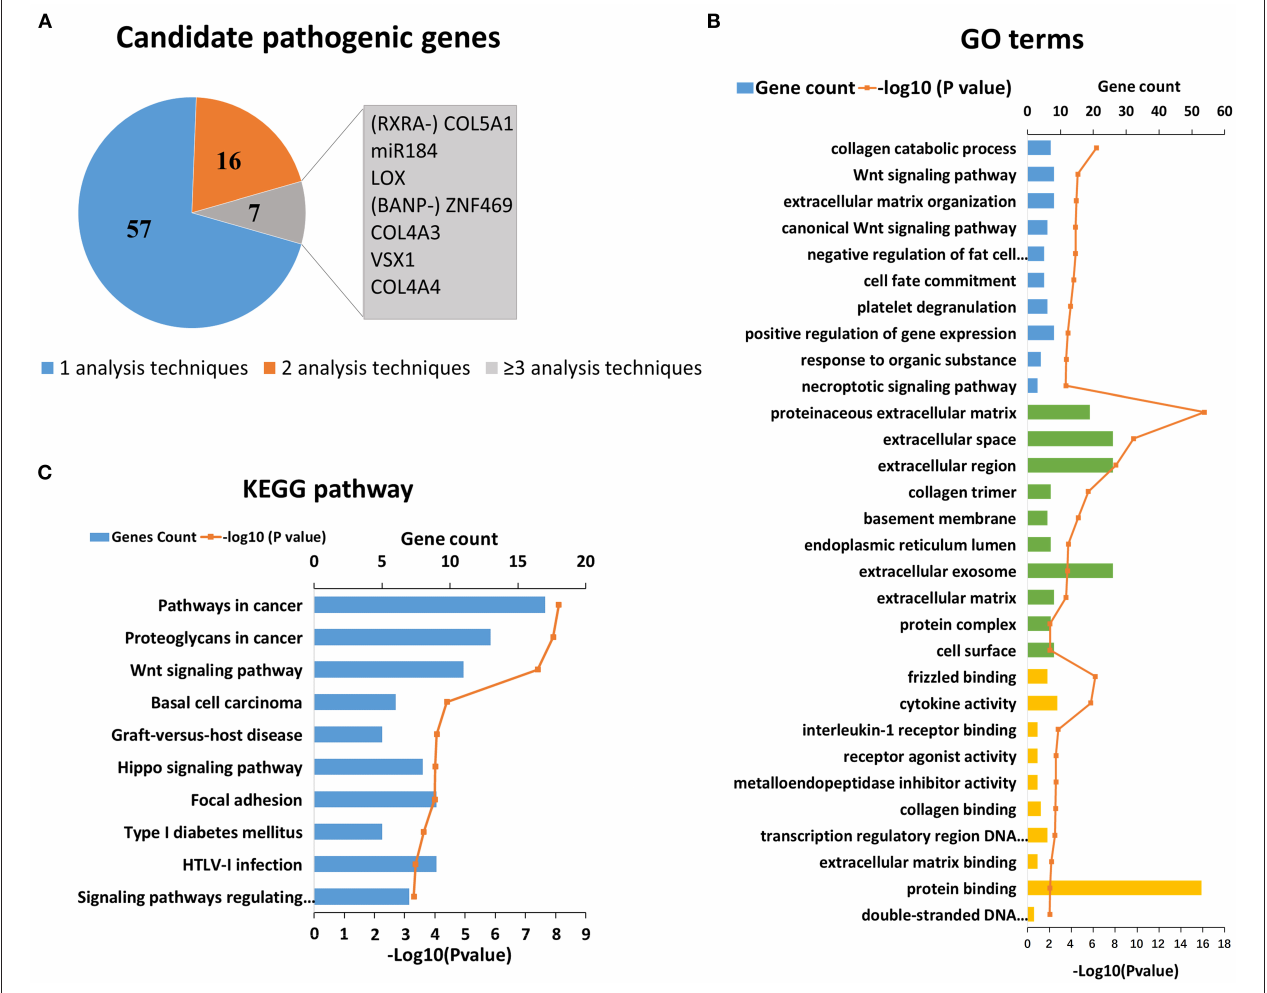
FIGURE 1 | Reported candidate genes in keratoconus at the DNA level. (A) The associated genes identified by different analysis techniques. (B) Top ten enriched terms of each GO category at the DNA level. The three colors represent biological process (blue), cell component (green), and molecular function (yellow), respectively. (C) Top ten enriched KEGG pathways at the DNA